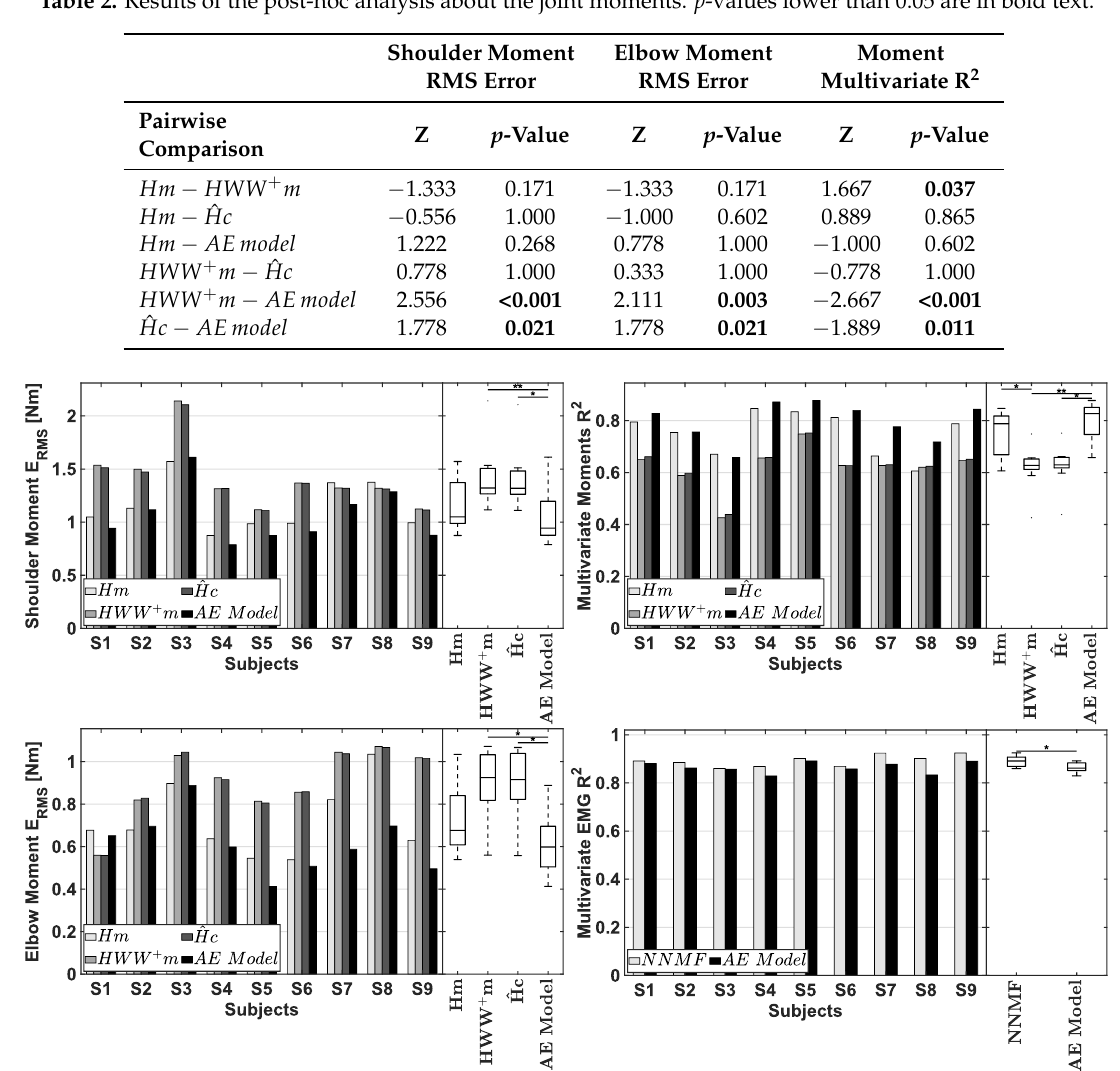
Figure 3. Results averaged among the test sets for each subject and each compared technique/model. Top-left . Shoulder moment E RMS errors. Bottom-left . Elbow moment E RMS errors. Top-right . Moment Multivariate R 2 index values. Bottom-right . sEMG Multivariate R 2 index